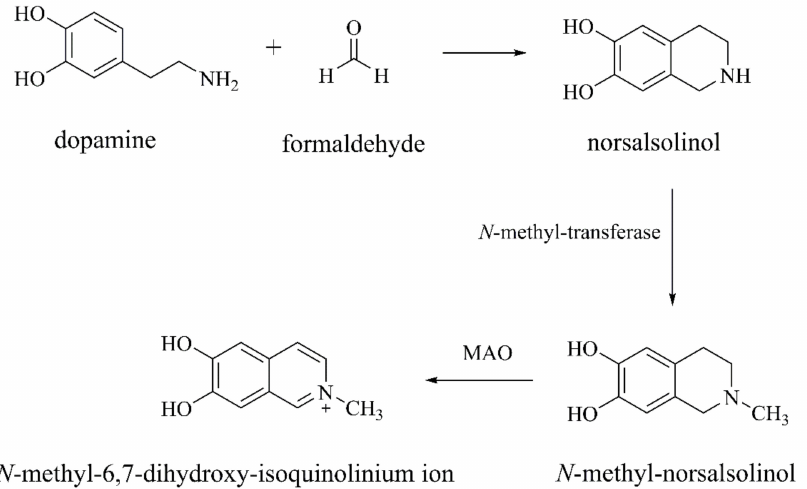
Figure 3. The biosynthesis and metabolism of norsalsolinol and N -methyl-norsalsolinol [32]. Salsolinol and